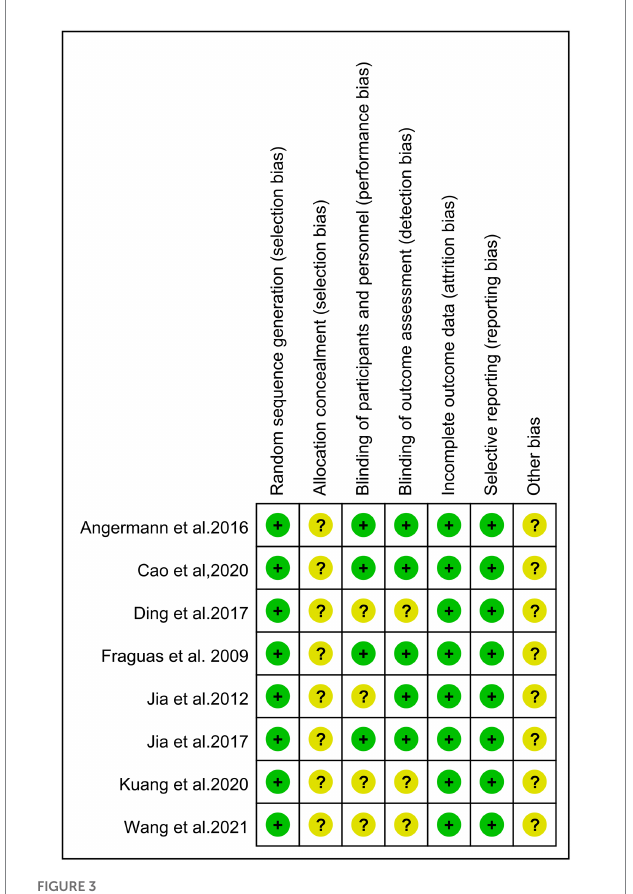
FIGURE 3 Risk of bias graph of included trials.